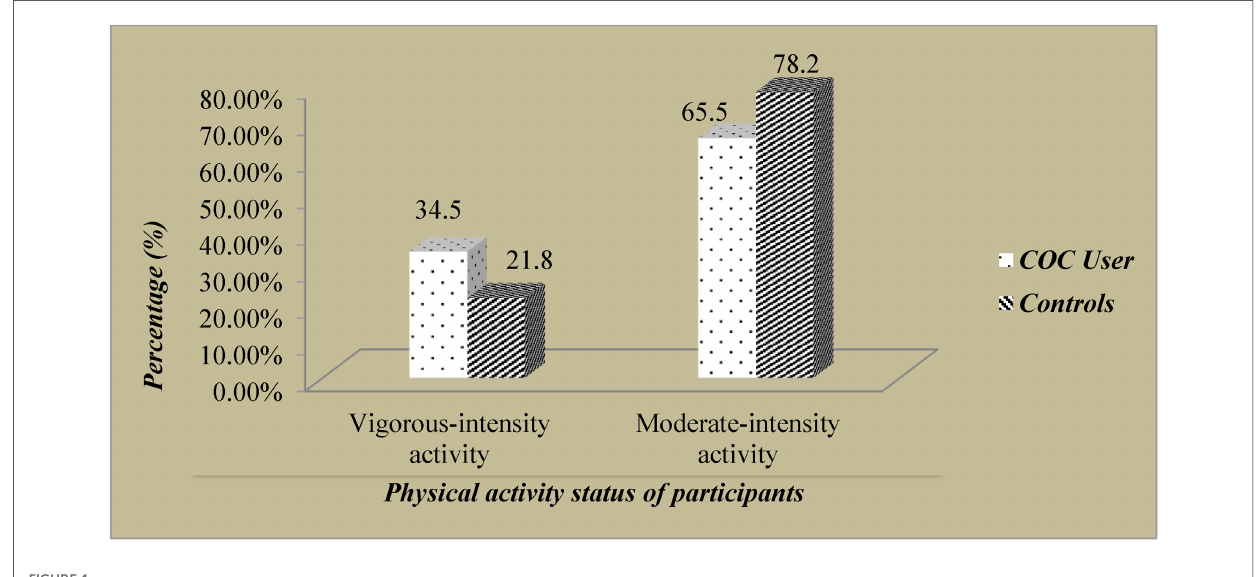
FIGURE 1 Participants ’ Physical Activity status in Chencha town, Southern